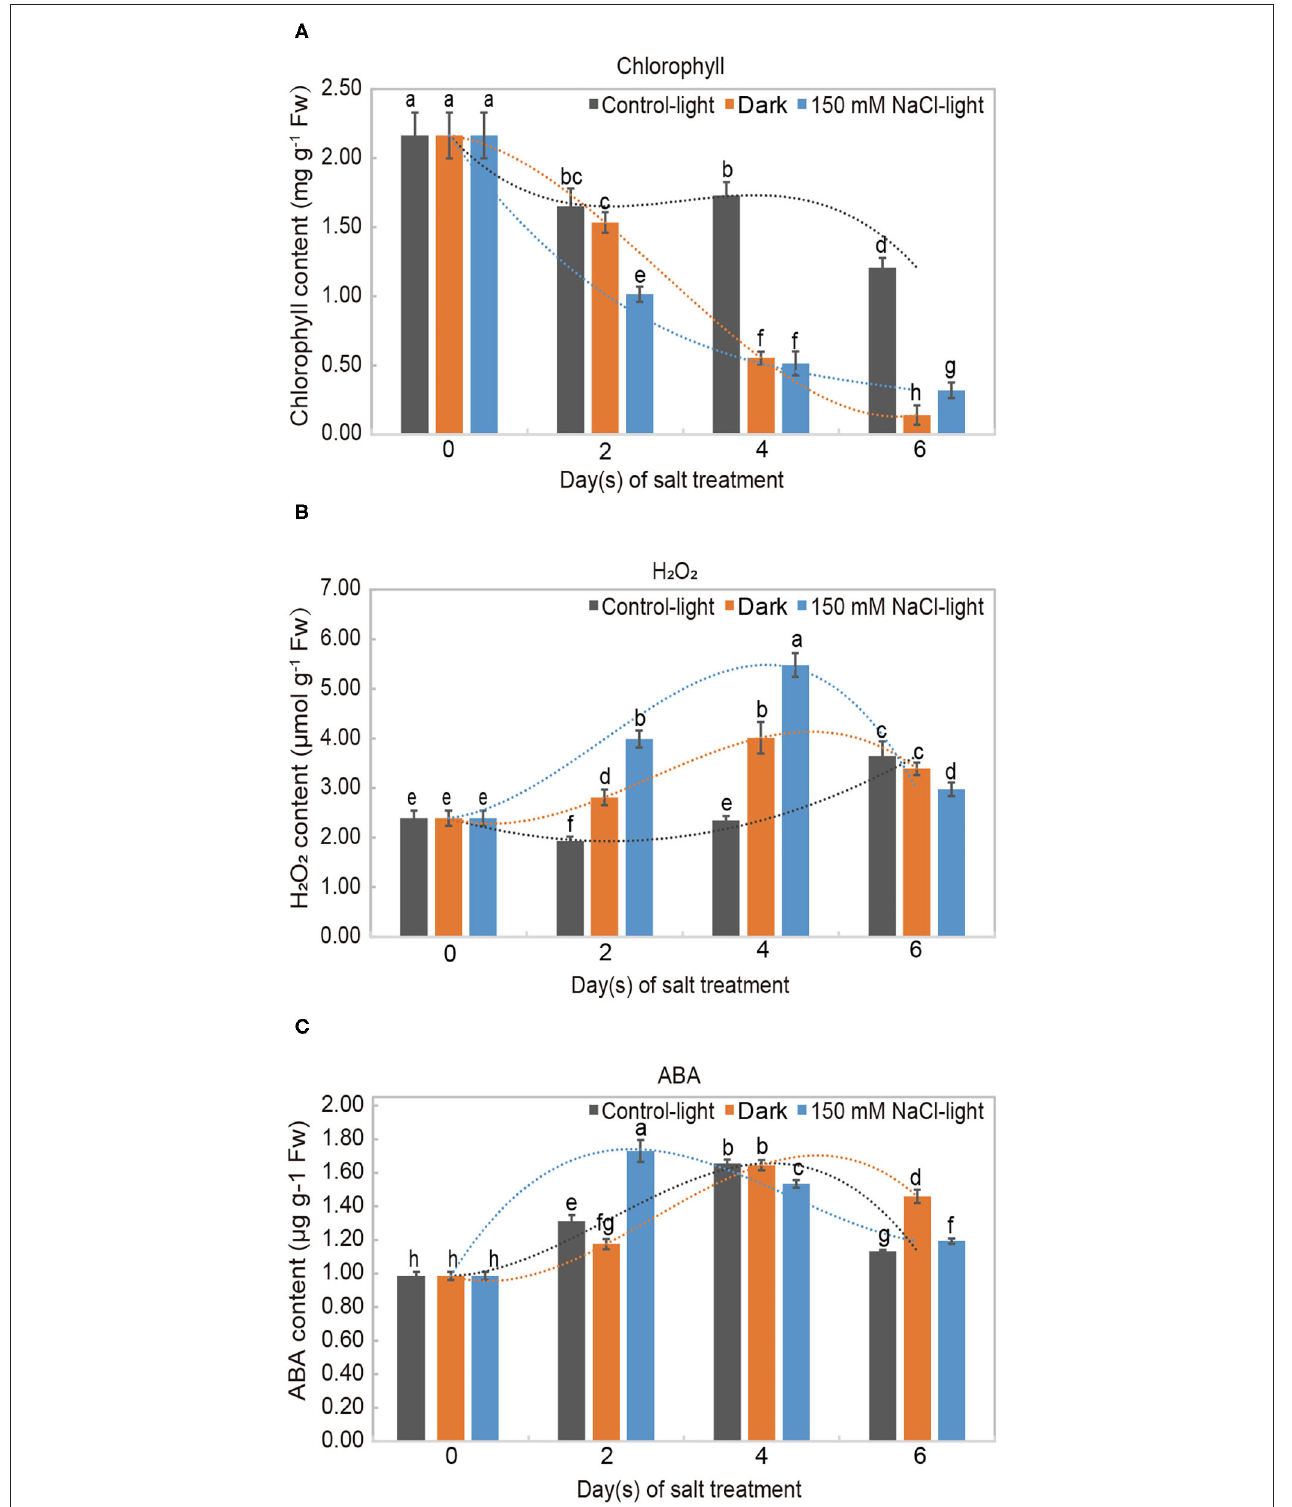
FIGURE 2 | Physiological analysis of salt-induced leaf senescence in Medicago truncatula . Levels of (A) chlorophyll (a + b), (B) hydrogen peroxide (H 2 O 2 ), and (C) abscisic acid (ABA) in detached Medicago truncatula leaves exposed to different conditions during leaf senescence. The values are presented as the mean ± SE values of three independent biological replicates per time point. Different letters indicate significant differences among treatments according to an analysis of variance (ANOVA, P < 0.05). Error bars correspond to standard errors. FW indicates fresh weight.